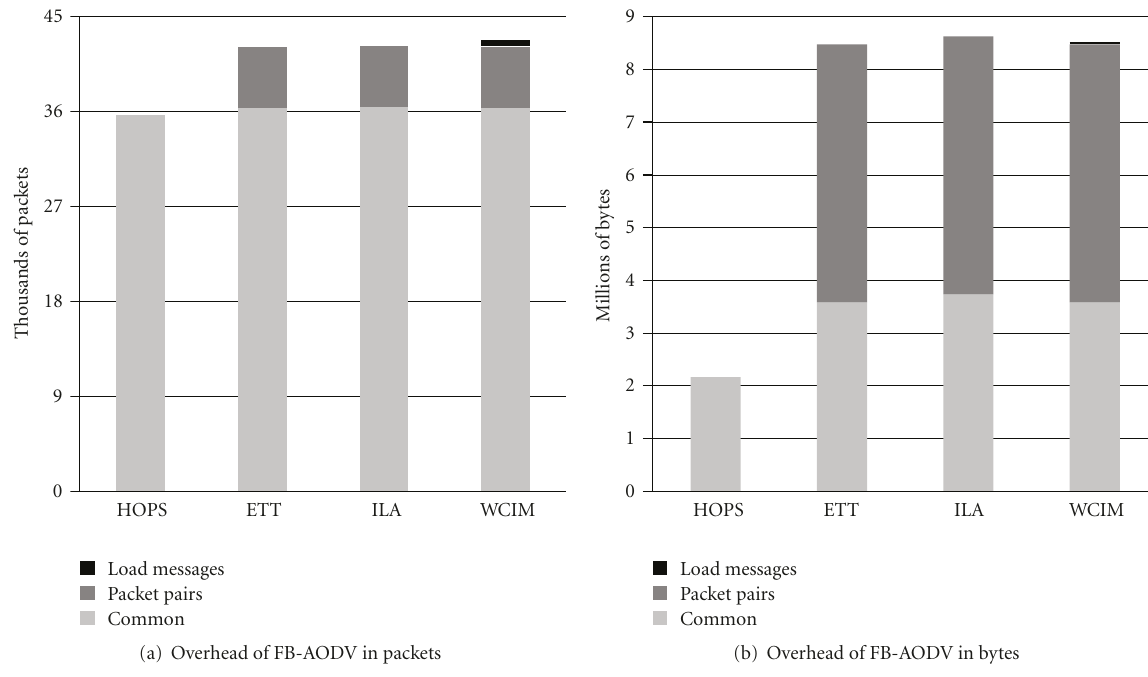
Figure 4: Overhead of FB-AODV: (a) in number of messages and (b) in number of sent bytes.